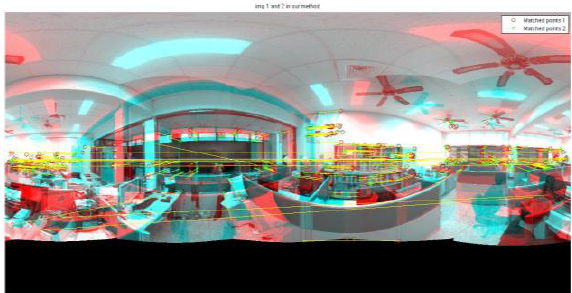
Figure 10(a). Movement test with Essential matrix model